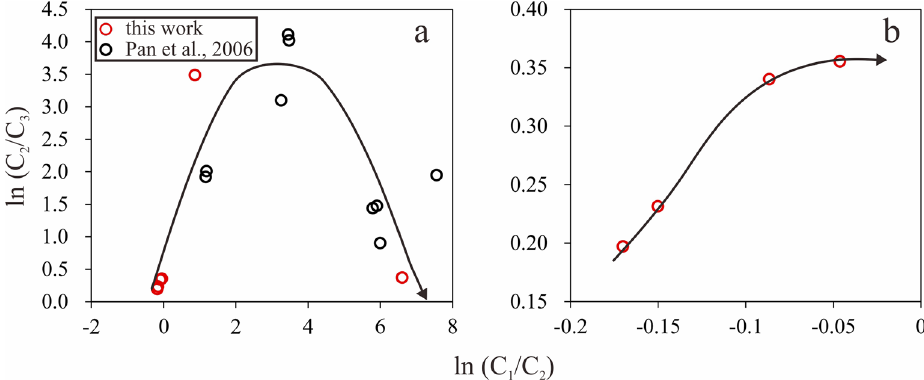
Figure 5. Co-variation of ln(C 1 /C 2 ) and ln(C 2 /C 3 ) with increasing TSR extent for the whole TSR process ( a ) and the initial uncatalyzed stage ( b